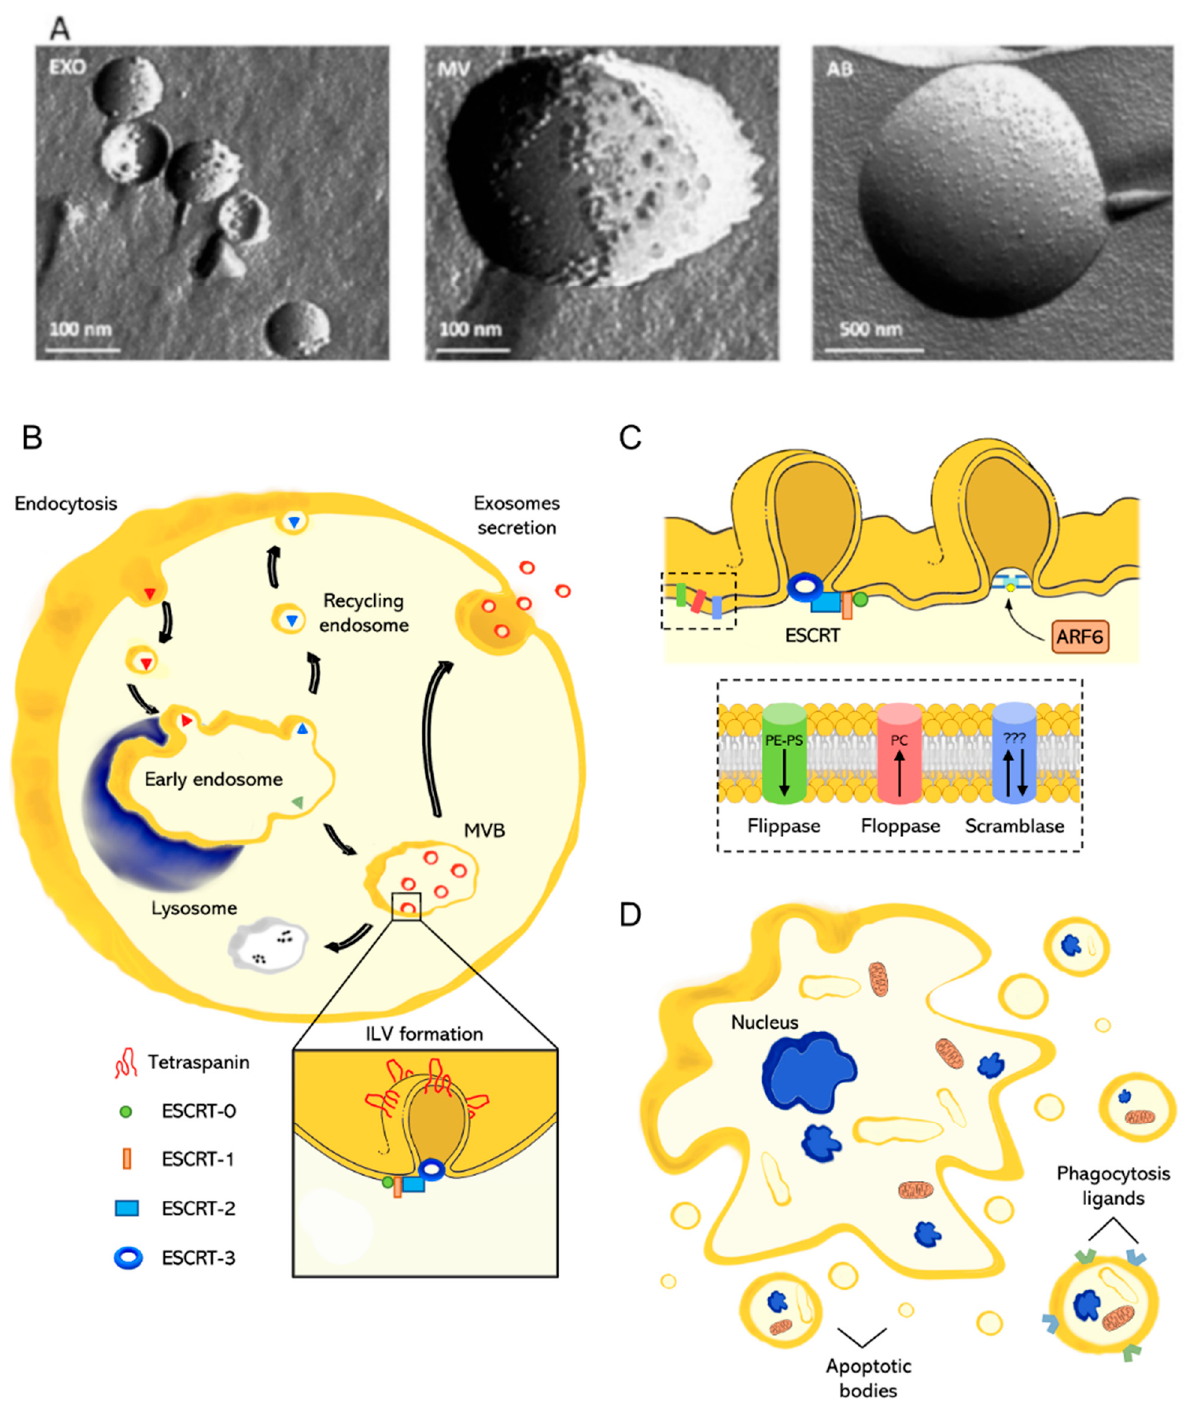
Figure 2. ( A ) EV classification and biogenesis: freeze-fracture transmission electron microscopy of the different EV types, reprinted with permission from ref. [25]. Copyright (2017 Elsevier). ( B ) Mechanisms of biogenesis of EXOs, with emphasis on the role of tetraspanins and ESCRT complexes; ( C ) mechanisms of MV biogenesis, with emphasis on the role of ARF6, ESCRT complexes, flippase, floppase, and scramblase. ( D ) Mechanism of formation of apoptotic bodies.